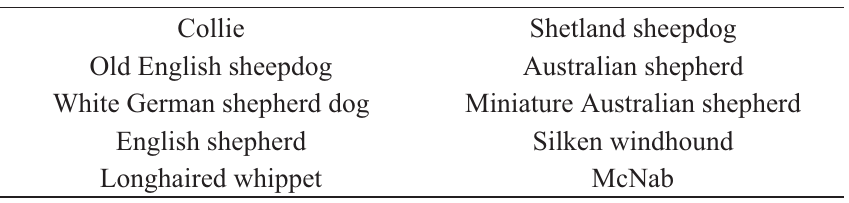
Table 5. Dog breeds with a high frequency of multidrug resistance (MDR)-1 gene deletion [80].